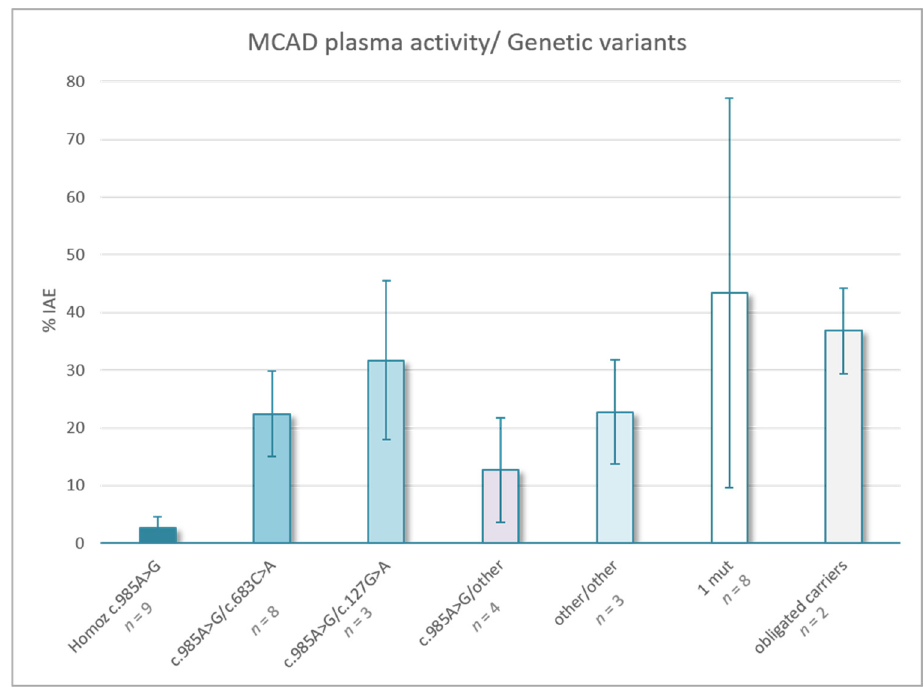
Figure 1. Enzymatic activity and correlation with genetic background of the